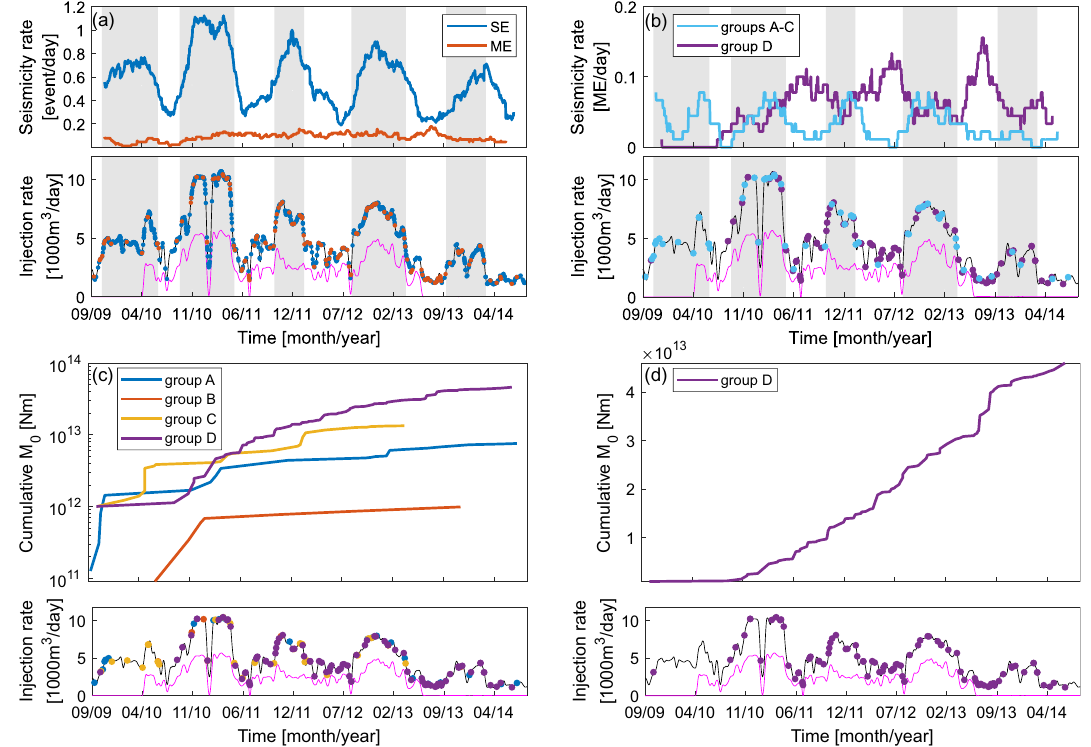
Figure 3. Seismicity rate of events calculated in moving window of 90 days in relation to injection rate: ( a ) SE and ME, ( b ) ME from groups A–C and D. Distinguished high injection periods are marked with gray. Cumulative seismic moment release in relation to injection rate: ( c ) ME from groups A–D in logarithmic scale, ( d ) ME from group D in linear